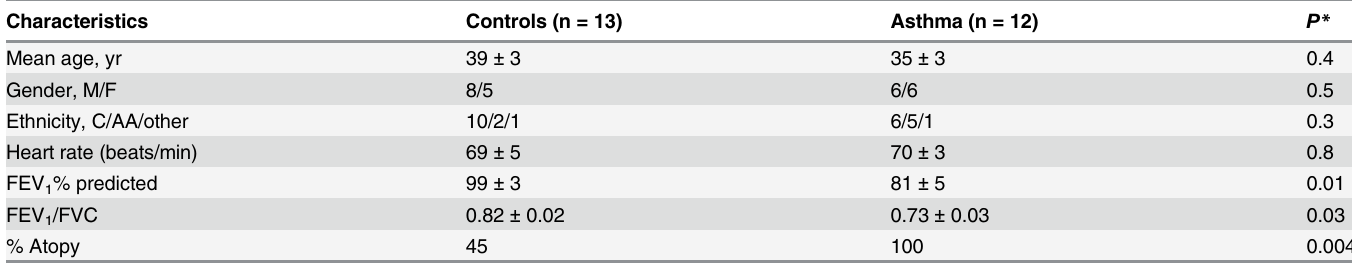
Table 1. Features of Study Participants.